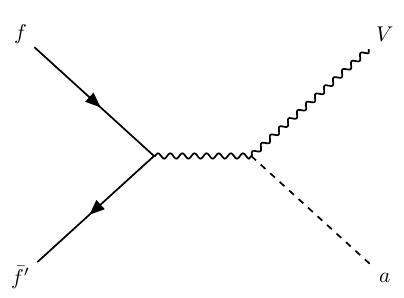
Figure 3 . Feynman diagram for ALP production associated with a SM vector boson.